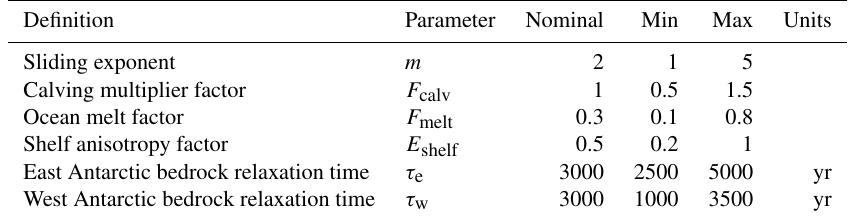
Table 1. List of parameters and parameter ranges used in the uncertainty analysis.